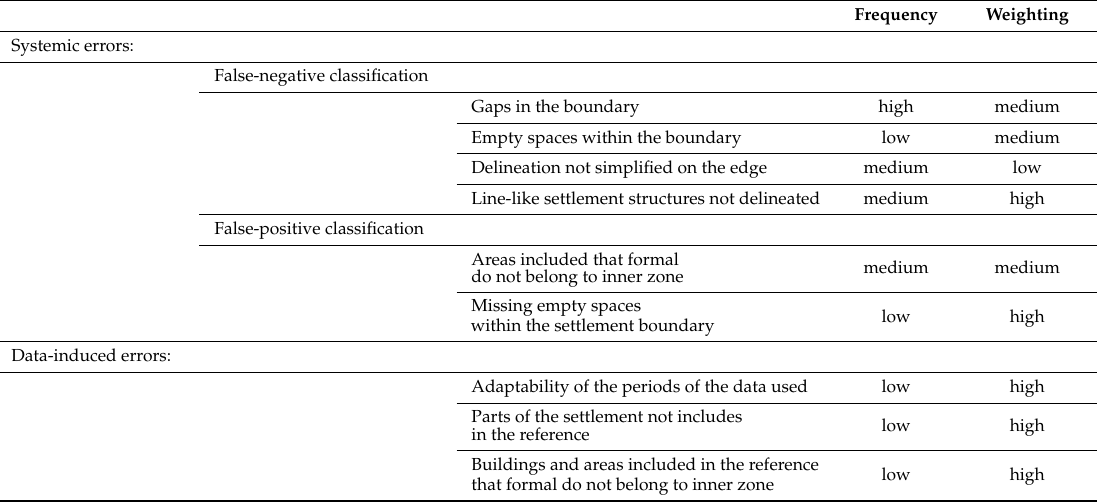
Table 7. Occurring errors and their qualitative assessment using the example of variant